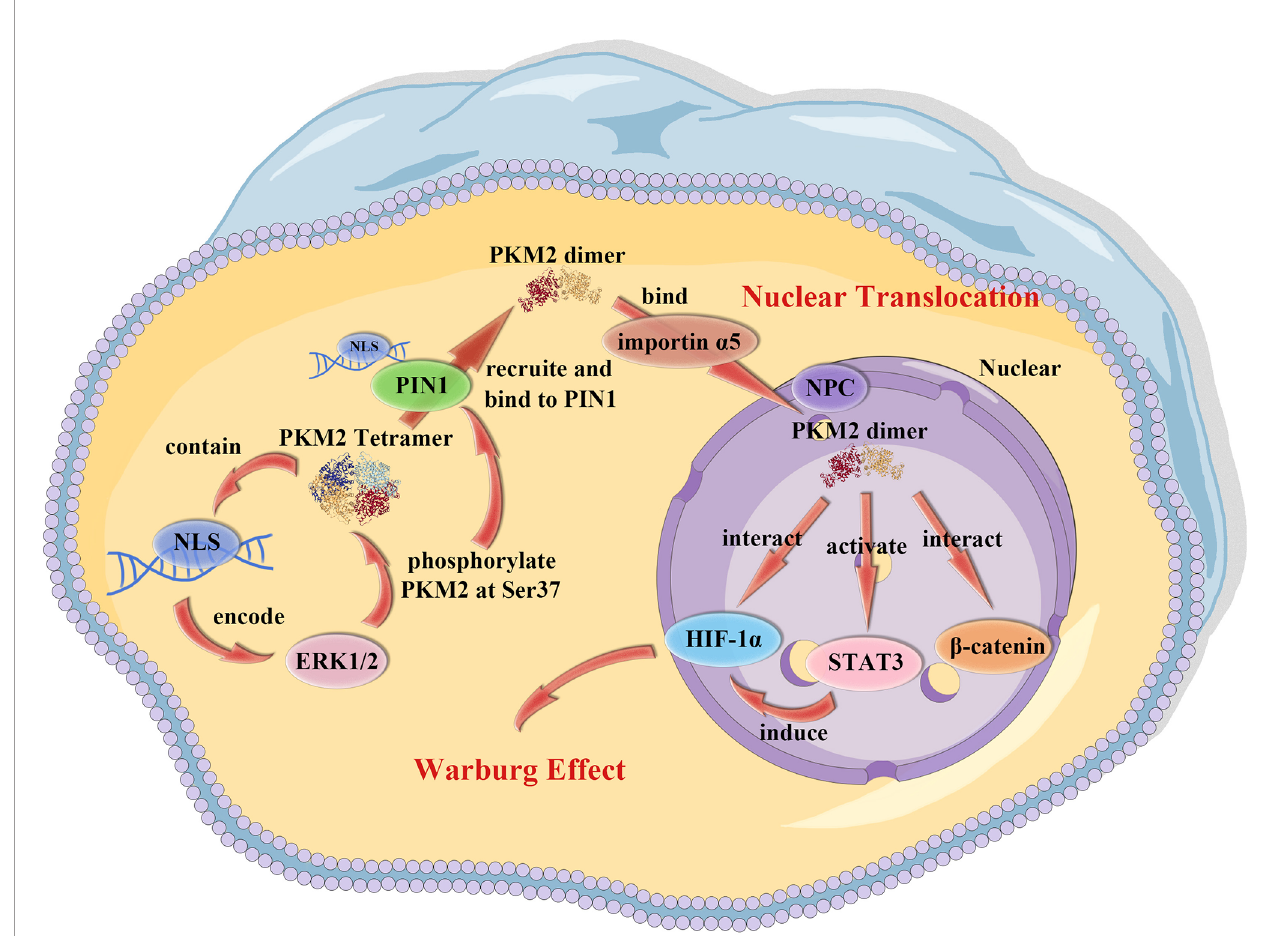
FIGURE 1 | PKM2 nuclear translocation. PKM2 contains a NLS that allows ERK1/2 to bind to and phosphorylate PKM2 at Ser37. The PKM2 tetramer than recruits and binds to the NLS on PIN1, leading to the conversion of PKM2 tetramer into a dimer/monomer. The dimer/monomer PKM2 binds to importin a 5 which links NLS-containing proteins to importin b and then docks the ternary complex at the NPC, inducing the translocation of PKM2 into the